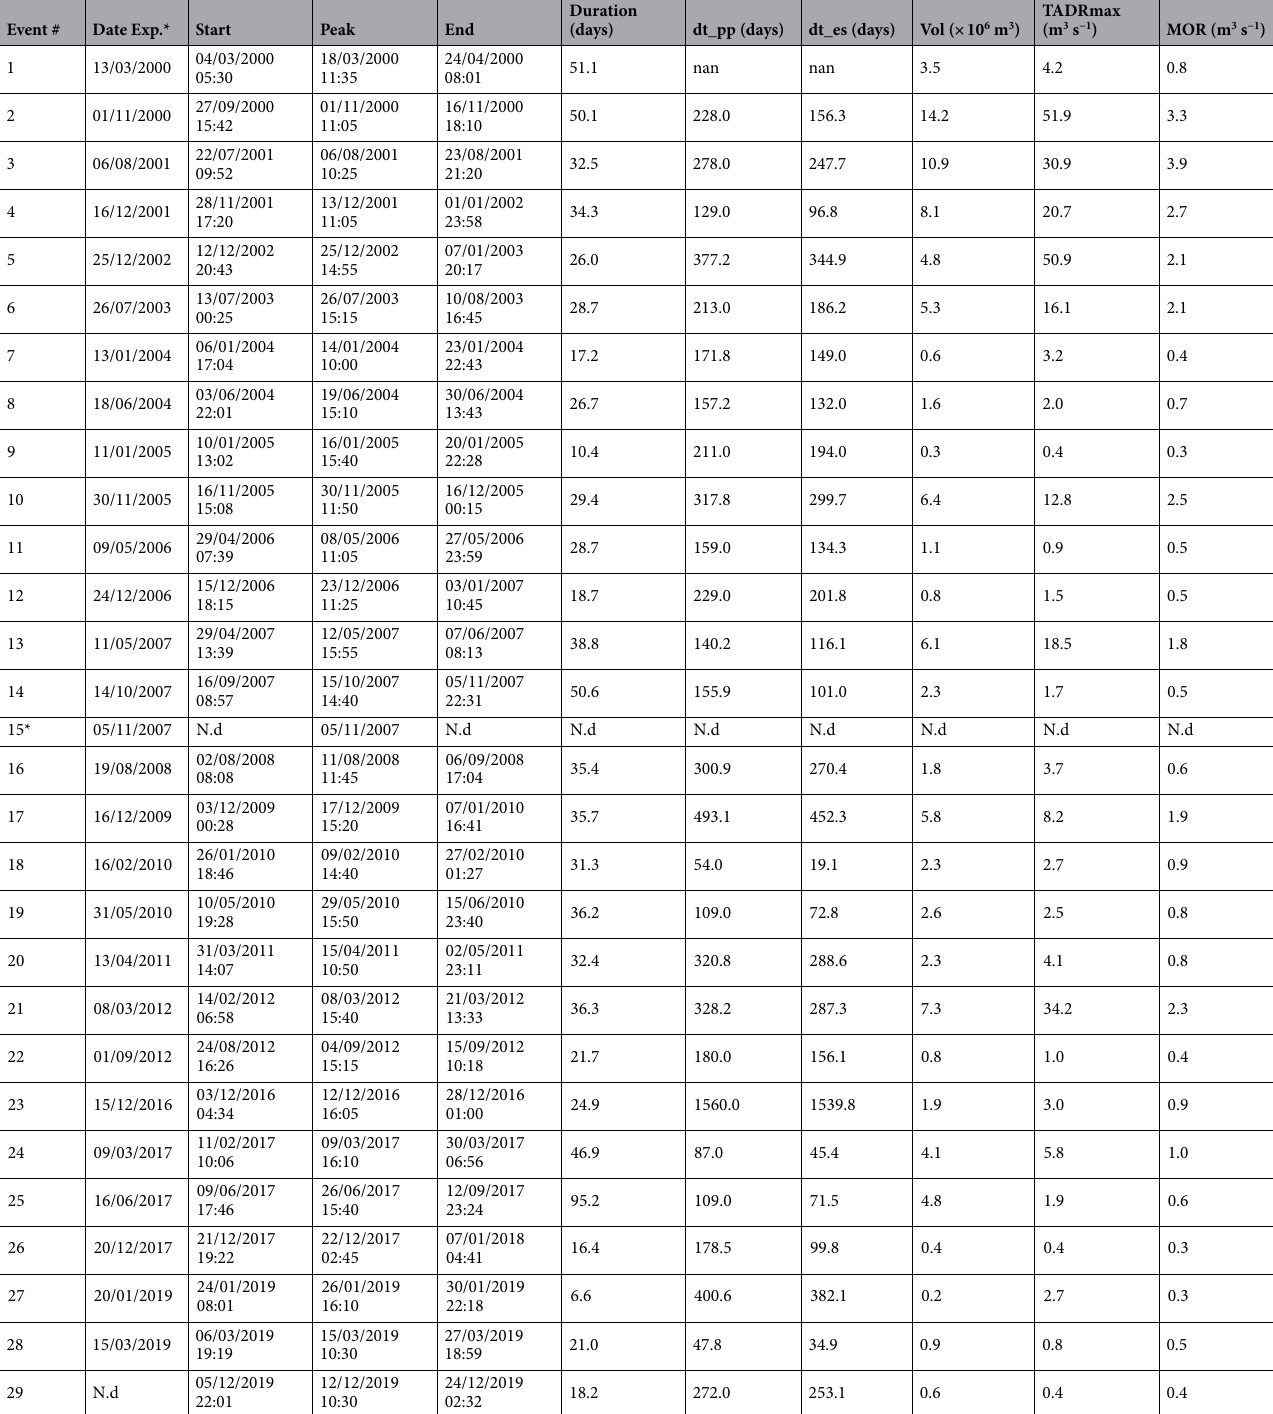
Table 2. Eruptions and parameters of Bezymianny retrieved from MODIS data. Volumes, TADR and MOR are calculated as bulk values (see “Methods”). *Date of explosion from Ozerov et al. 41 . **Event #15 not detected by MODIS but reported in Ozerov et al. 41